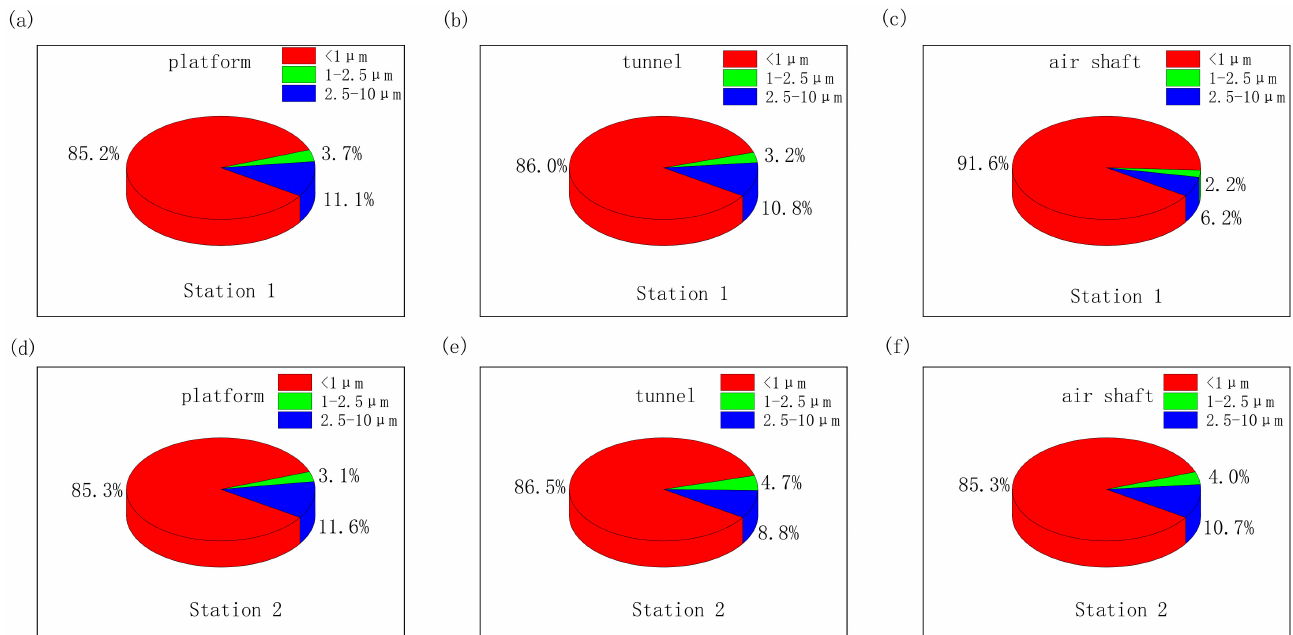
Figure 5. The particle size composition of PM10 ( a ) on the platform at Station 1; ( b ) in the tunnel at Station 1; ( c ) in the air shaft at Station 1; ( d ) on the platform at Station 2; ( e ) in the tunnel at Station 2; and ( f ) in the air shaft at Station 2.